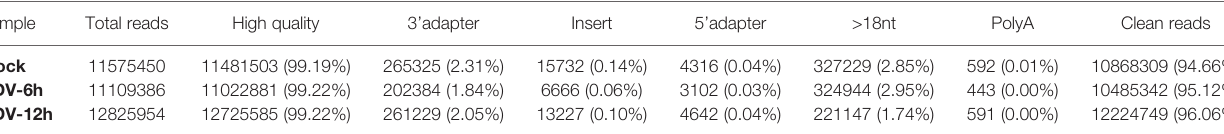
TABLE 2 | Overview of the deep sequencing data of each group.